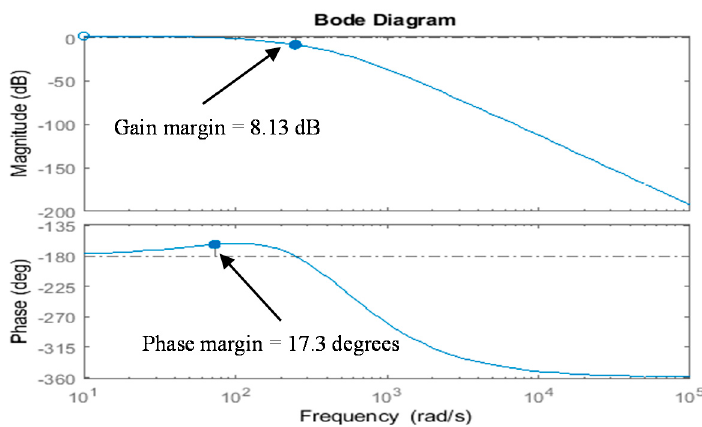
Figure 6. The frequency response of AMB plant in y -plane.